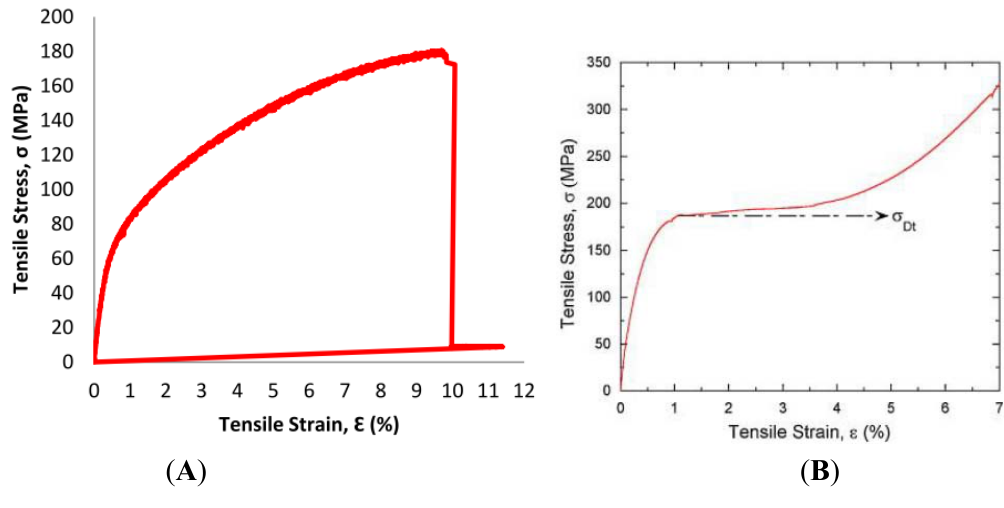
Figure 8. Stress-strain behavior from tensile testing of Mg-Zn-Cu and Mg-Zn-Se alloys compared to martensitic nitinol. ( A ) Room temperature tensile stress-strain response of the Mg-Zn-Se alloy; ( B ) Quasi-static, room temperature tensile stress–strain response of the martensitic Nitinol alloy [11]. ( C ) Room temperature tensile stress-strain response of the Mg-Zn-Cu